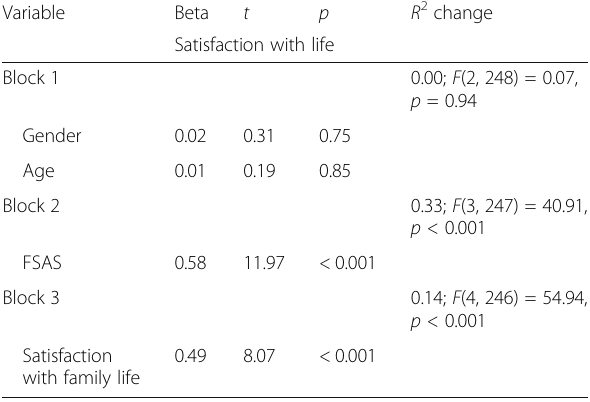
Table 3 Hierarchical multiple regression of satisfaction with life onto demographic variables, FSAS, and satisfaction with family life